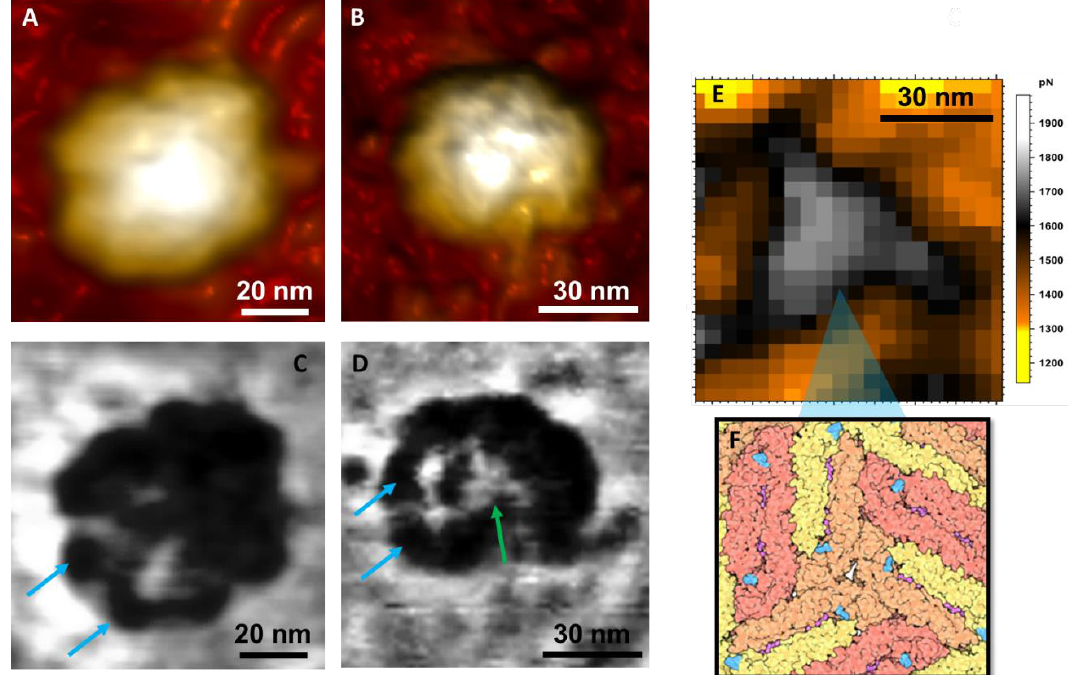
Figure 3. ( A , B ) Topographic maps of AFM revealing the viral ultrastructure and particle shape of ZIKV; ( C , D ) their respective adhesion maps. ( E ) Closeup adhesion map, showing the correlation between the triangular-shaped structure observed and the model based on cryo-EM results in ( F ) [42]. The blue arrows on both ( C , D ) maps indicate the typical bumps of the mature ZIKV particle. The green arrow ( D ) points to the triangular conformation of the closely fitted E protein structures.